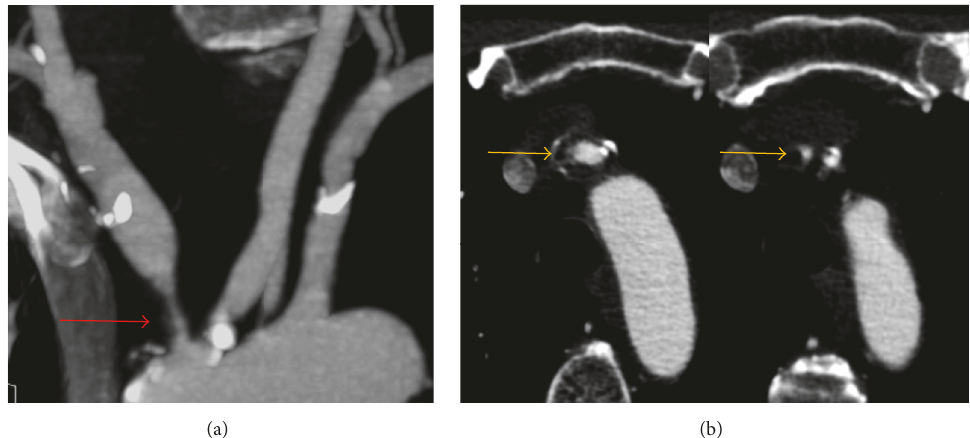
Figure 1: (a) A sagittal plane of the CT angiography shows critical stenosis of innominate and left carotid artery emerging from a bovine arch (red arrow). (b) In the axial plane, a vulnerable plaque includes the common trunk and the origin of the innominate and left common carotid artery (yellow